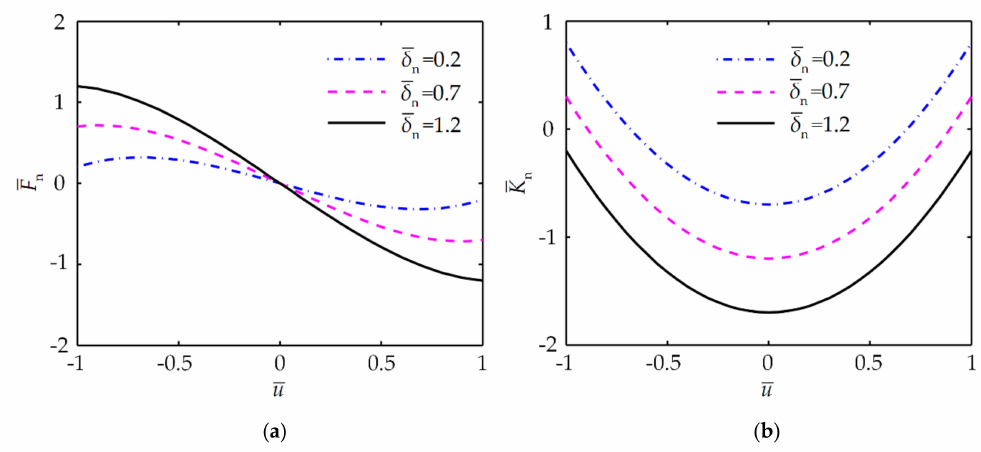
Figure 4. Non-dimensional characteristics of QCRM with a = 0.5. ( a ) Force-displacement curves; ( b ) sti ff ness